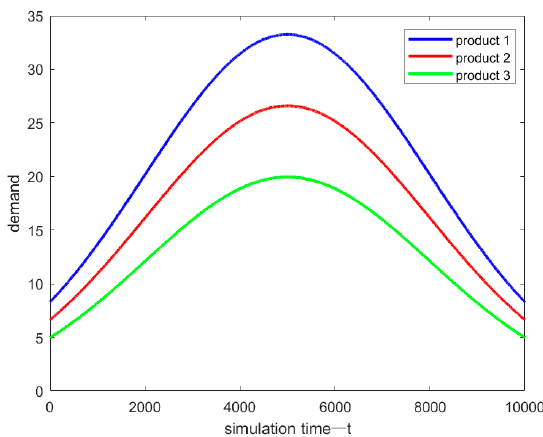
Figure 2. The demands of three product types.